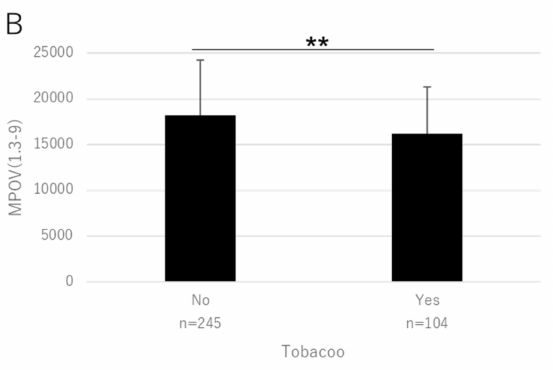
Figure 6. Mean MPOV in patients in relation to their smoking history. ( A ) MPOV(0.5) (* p = 0.0040). ( B ) MPOV(1.3–9) (** p = 0.0010, mixed linear model). Bar represents standard